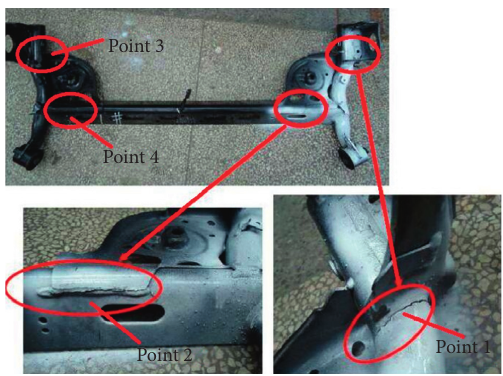
Figure 4: Measuring points of the automotive suspension.